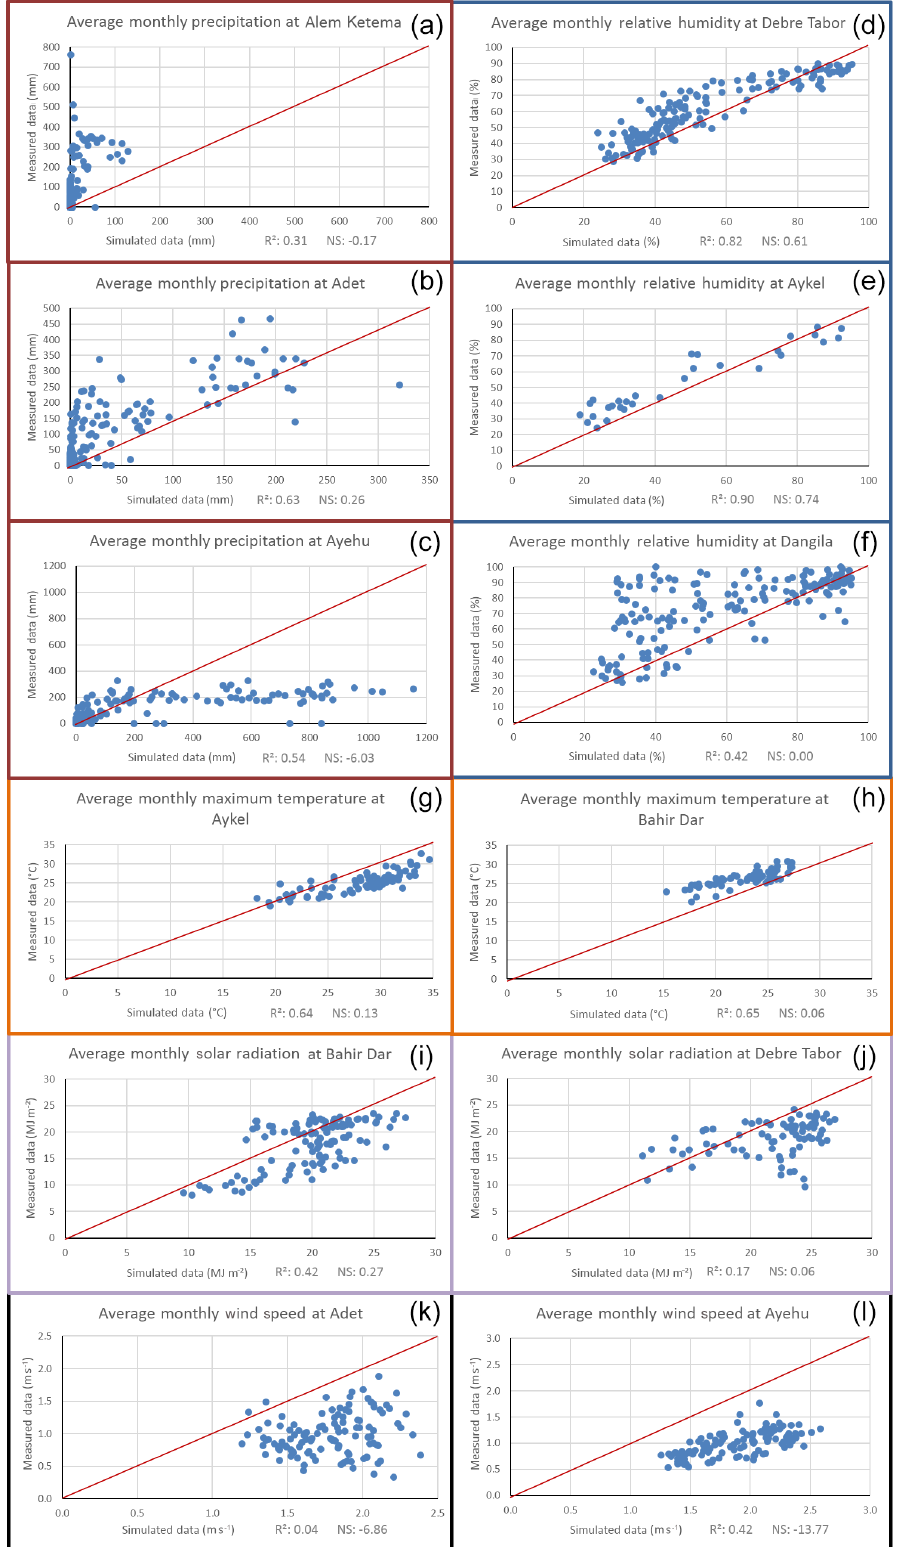
Figure 6. Significance of matching between the ground and CFSR weather datasets. Panels (a–c) are average monthly precipitation; (d– f) are average monthly relative humidity; (g, h) are average monthly maximum temperatures; (i, j) are average monthly solar radiation; and (k, l) are average monthly wind